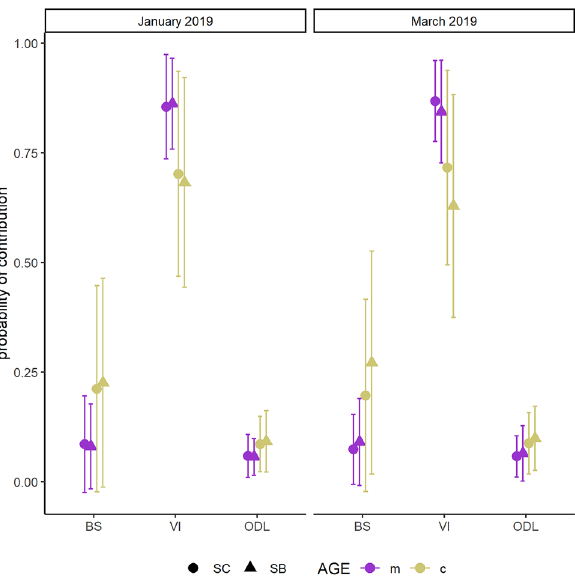
Figure 4. Predicted percentages of contribution of the three sources (BS = Bering Sea, VI = Vancouver Island, ODL = Ojo de Liebre Lagoon) to the isotopic mixture of the mother-calf pair collected and recollected in January 2019 and March 2019. For calf, SC and SB are representing estimated placental blood and maternal milk.